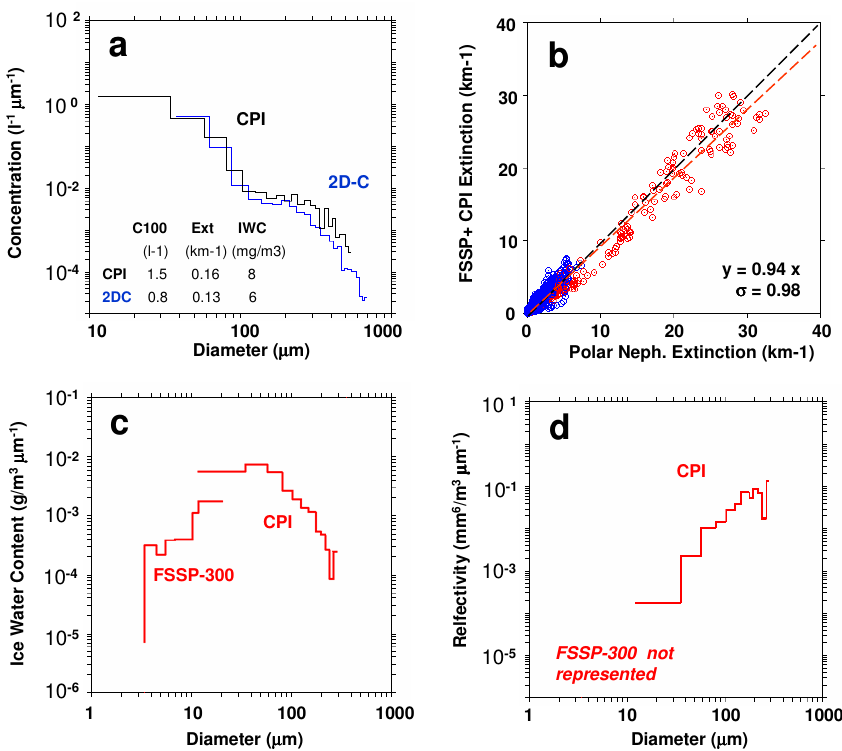
Fig. B1. (a) : Composite representation of the size distributions measured simultaneously by the CPI and the 2-D-C probes (CIRCLE-2 16 May flight, 8:57:00–9:01:30UT); (b) : Comparison between extinction coefficients from Polar Nephelometer probe and combined FSSP-300 and CPI instruments. The red and blue dots relate the overshooting cell and the cirrus measurements, respectively. The slope parameters and correlation coefficients are reported; (c) : Ice water content size distributions (overshooting cell) and (d) : Reflectivity factor size distribution (overshooting